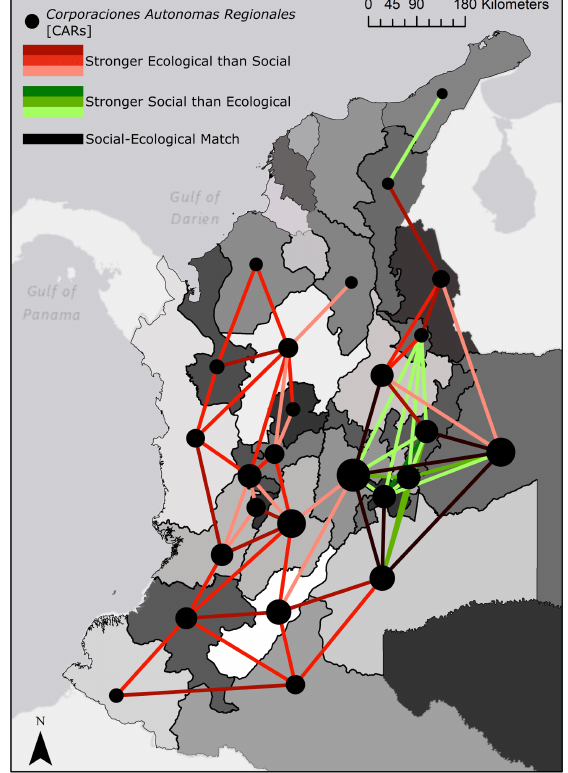
corporations ( corporaciones autonomas regionales [CARs]) with respect to Andean bear ( Tremarctos ornatus ) conservation and research across the Colombian Andes. Social-ecological matches and mismatches are premised on the degree of alignment between the strengths of institutional and ecological ties between the CARs. Nodes are sized by ecological degree